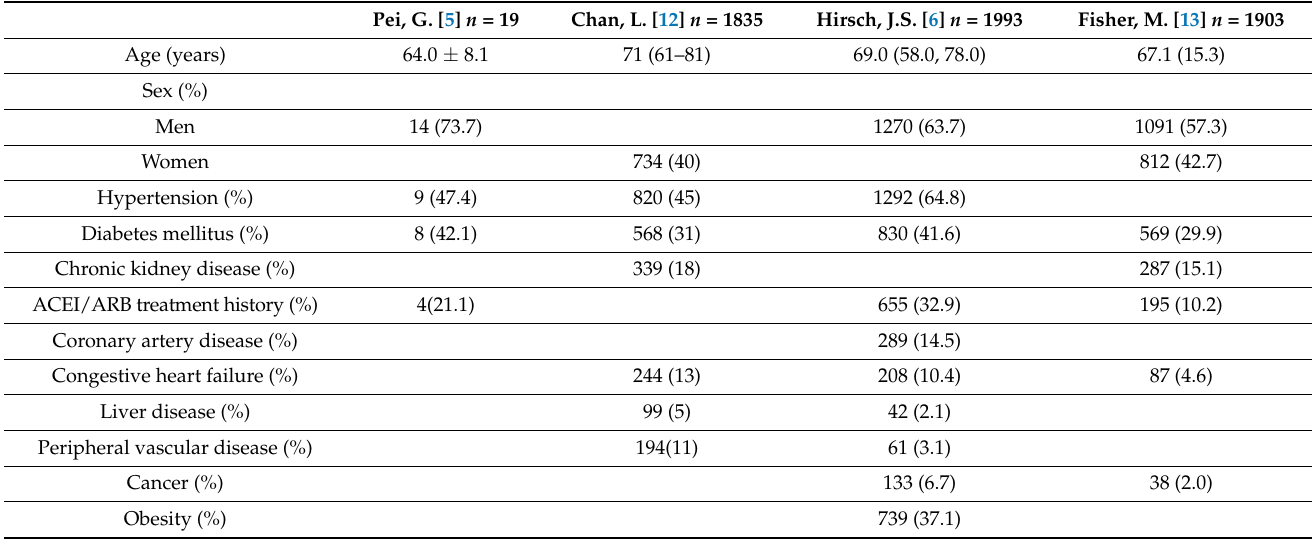
Table 4. The correlation between age, sex, comorbid conditions and AKI development.